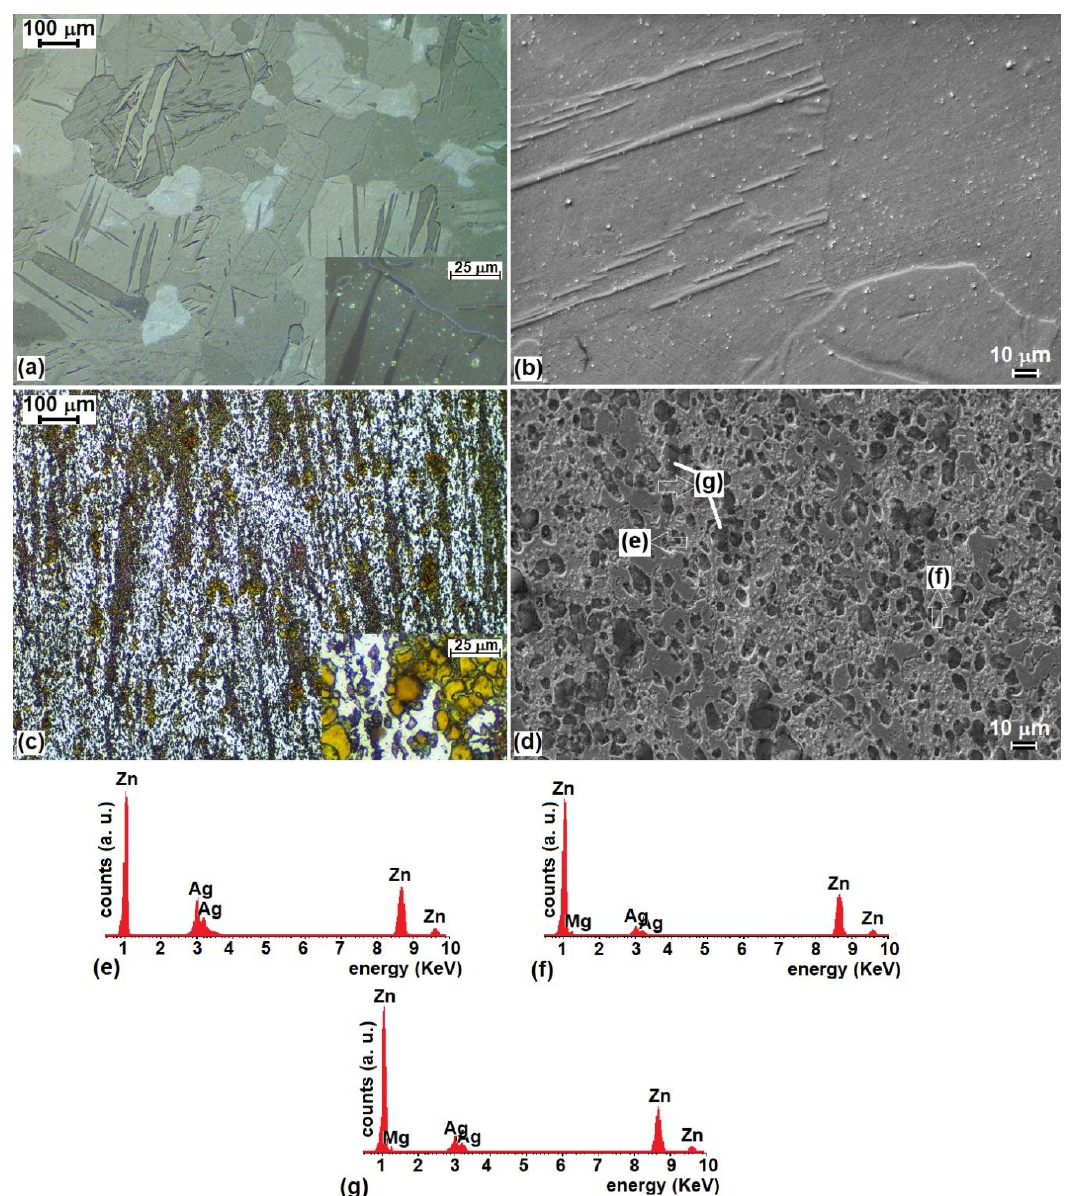
Figure 5. Optical and SEM micrographs of the extruded condition of ( a , b ) Zn-1Mg alloy; ( c , d ) Zn- 12.5Ag-1Mg alloy, respectively; ( e – g ) EDS spectra corresponding to points E, F, and G from Figure